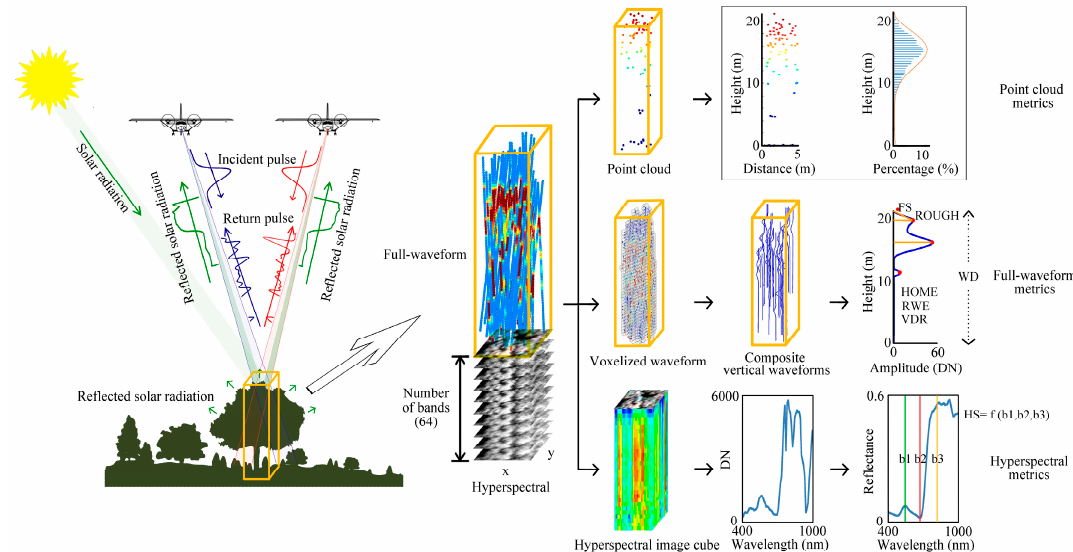
Figure 3. The framework of integration of simultaneously acquired airborne full-waveform (FWF) LiDAR and hyperspectral data (including the processes of data acquisition, datasets integration and metrics extraction). DN = Digital Number.